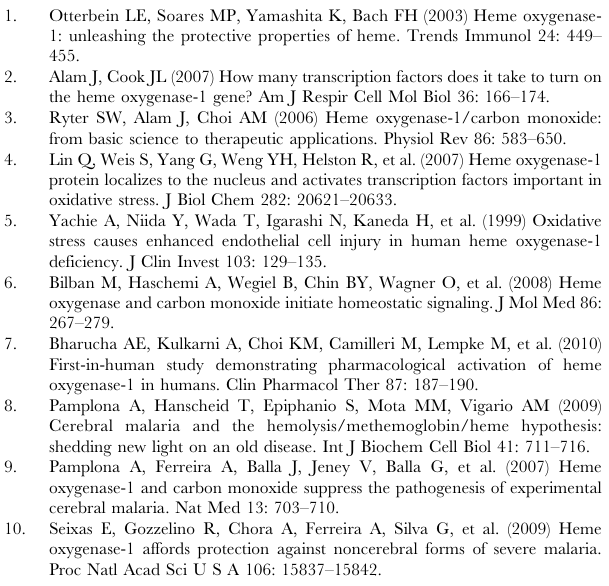
age, gender, duration of symptoms and Hb. The red lines show the medians. Figure S2 Correlation between HO-1 and indirect bilirubin in plasma is shown for A) severe (n= 46, r: 0.69 p , 0.0001) and B) uncomplicated malaria (n= 14, r: 0.77, p = 0.0012) cases. Figure S3 Possible confounding factors. The percentage of A) sickle cell trait carriers and B) children who are heterozygous (girls)or hemizygous (boys) carriers for the GdA 2 variant of G 6PD deficiency are shown amongst severe (SM) or uncomplicated (UM) malaria cases, or amongst those classified as ‘L’ or ‘non-L carriers’ for the (GT) n repeats. C) The percentage of children with blood group O is shown according to disease entity (left), or HMOX1 promoter genotype (right). Error bars indicate the 95% CI for proportions, calculated using the Wilson method. P values are given for Fisher’s exact test (A), or Chi Square test (B and C), respectively. D) Histidin rich protein-2 levels are shown according to disease entity (left), or HMOX1 promoter genotype (right). The red line indicates the geometric mean. The p-value refers to regression analyses performed on log transformed data. (SP = se- vere prostration, SA= severe anaemia, CM =cerebral malaria, SRD = severe respiratory distress, UM = uncomplicated malaria). Figure S4 HapMap LD structure of the HMOX1 locus. The (GT) n promoter polymorphism is located 138 bp upstream from rs2071746, at the left end of the 6 kb block. LD blocks are in the HaploView format, with both D’ and r2 values shown. Figure S5 HO-1 plasma levels and HMOX1 mRNA levels according to HMOX1 promoter genotype. A) HO-1 plasma levels and B) HMOX1 mRNA levels are shown for HMOX1 promoter genotypes, constituted of ‘‘S’’ (short , 27), ‘‘M’’ (medium 27 to 32) and L (long . 32) [GT] n repeats alleles. The red line indicates the